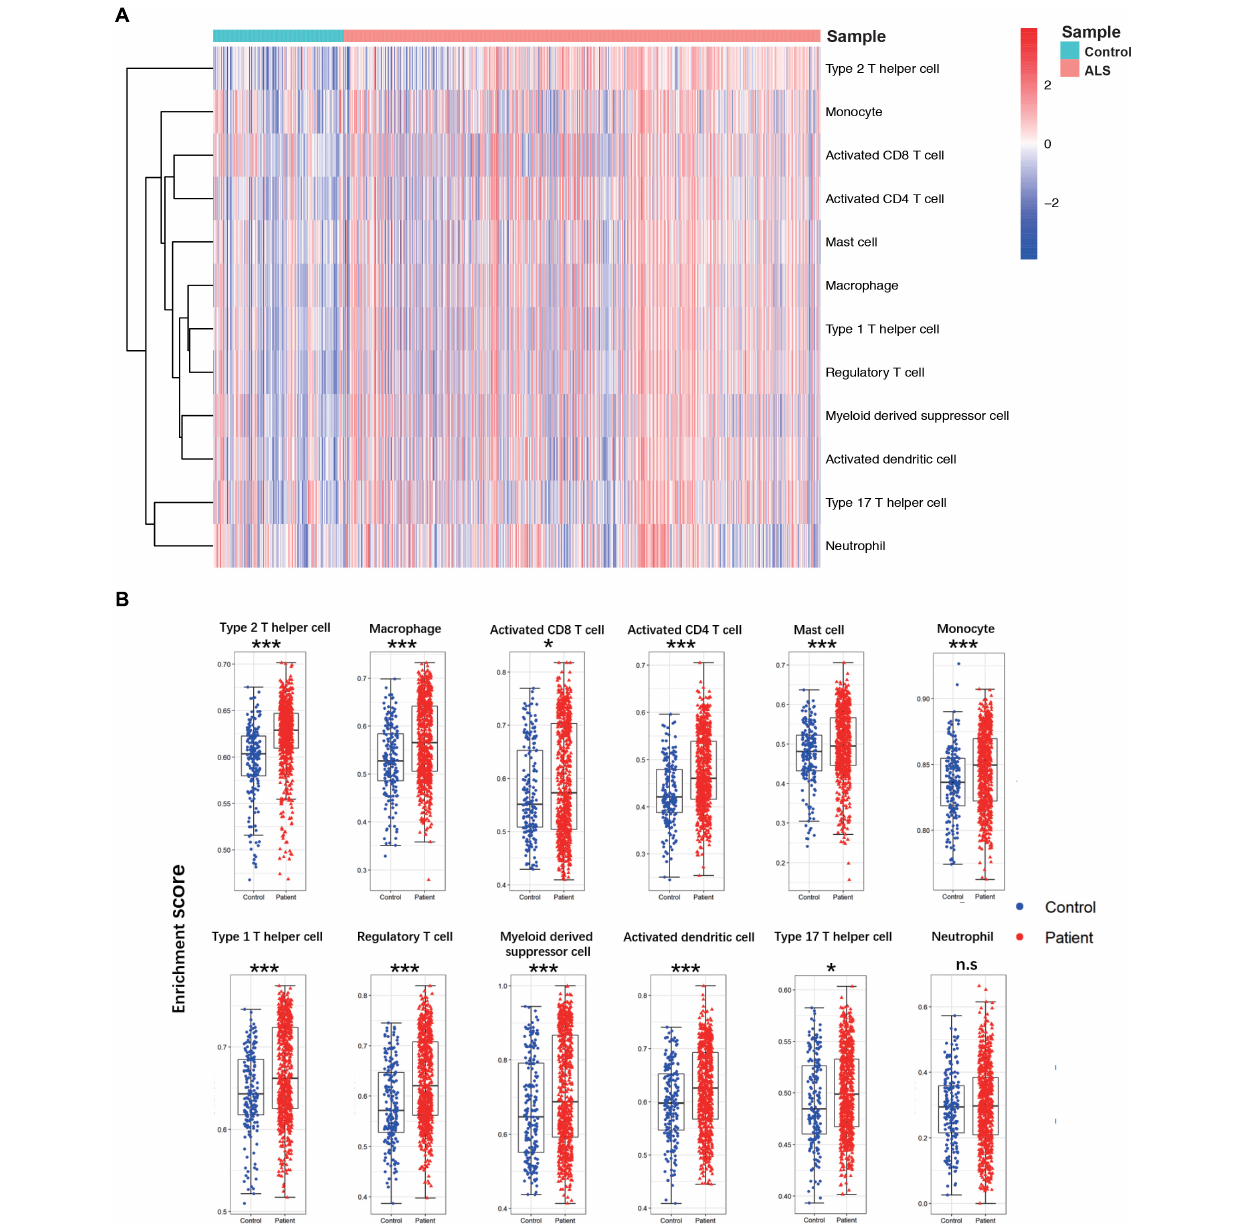
FIGURE 2 | The landscape of immune cell infiltration between ALS patients and non-neurological control subjects. (A) A heatmap of 12 immune cell infiltration based on single-sample gene set enrichment analysis. (B) Boxplot of comparisons of 12 immune-cell enrichment scores. The enrichment score of macrophages, Tregs, Th1, Th2, Th17, activated CD4 + T cells, activated CD8 + T cells, monocytes, activated dendritic cells, and mast cells myeloid-derived suppressor cells were higher in ALS patients than non-neurological control. * p < 0.05, ** p < 0.01, *** p <